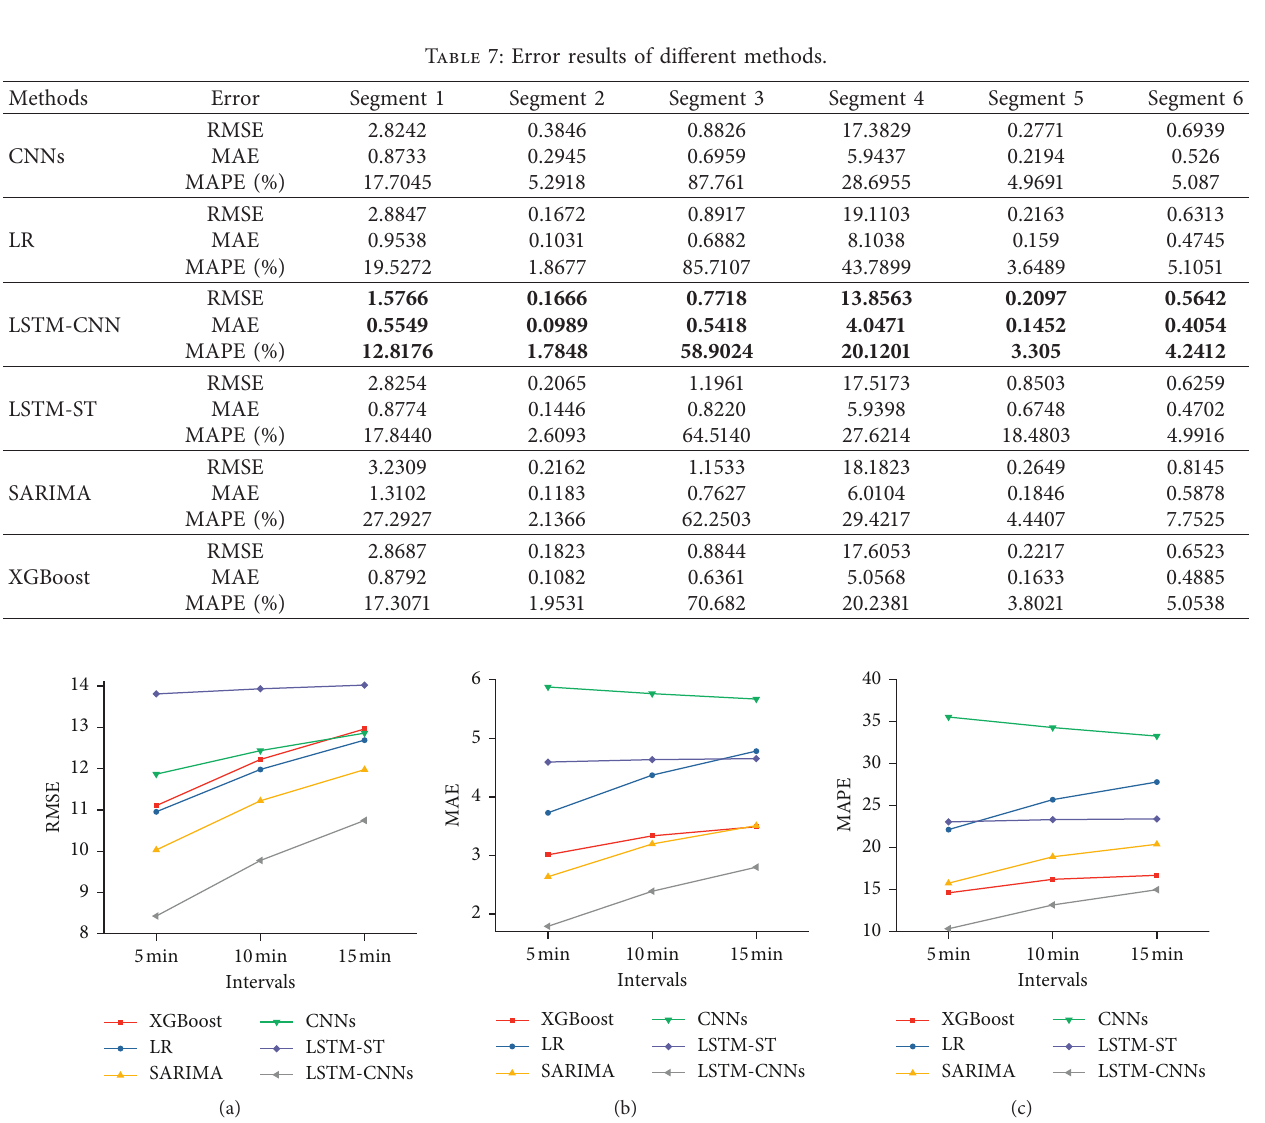
Figure 14: Short-term prediction error